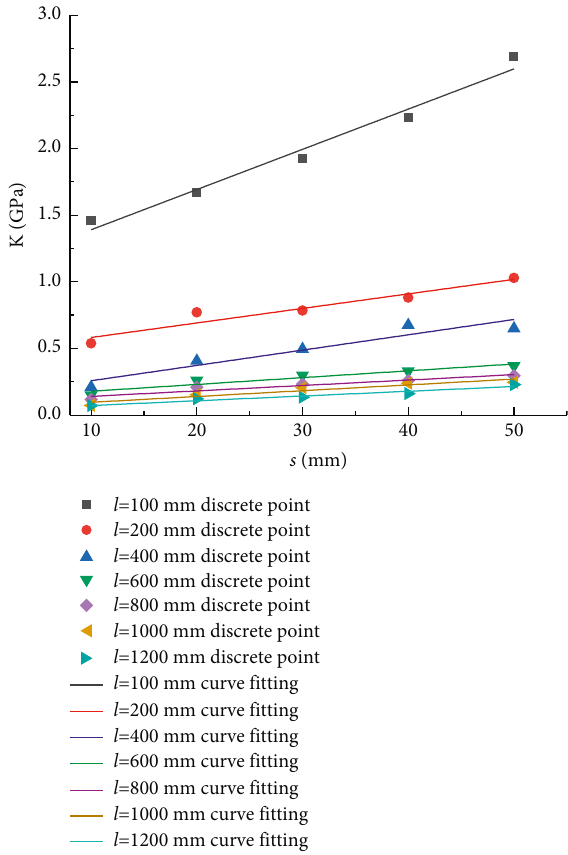
Figure 3: Fitting curves of bulk modulus and PJS. Table 5: Fitting relationships between K and PJS.